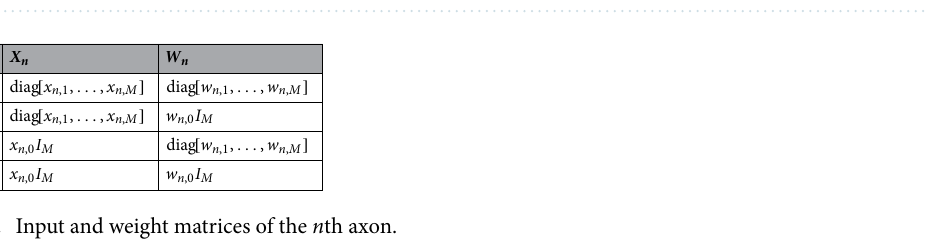
Figure 3. ( b ) Schematic of an autoencoder and ( a ), ( c ) its two FC layers implemented over PPNN in mode #3 where channels correspond to unique weight vectors and outputs y m . Based on the connectivity graph from ( b ), the implementation assumes the use of ( a ) 4 branches and 2 wavelengths in the first layer and ( c ) 2 branches and 4 wavelengths in the second one. If the number of available branches N is greater than needed, all the excess branches will have the inputs set to 0 (observe the N th branch in ( a ), ( c ), where the condition N > 4 and N > 2 4 to denote that the lit n th branch is imposed, respectively). Index n in the implementation ( a ) is set to n ≤ carries a non-zero input. Similarly, if the number of available wavelengths M exceeds the number of required ones, the excess LDs are powered off.